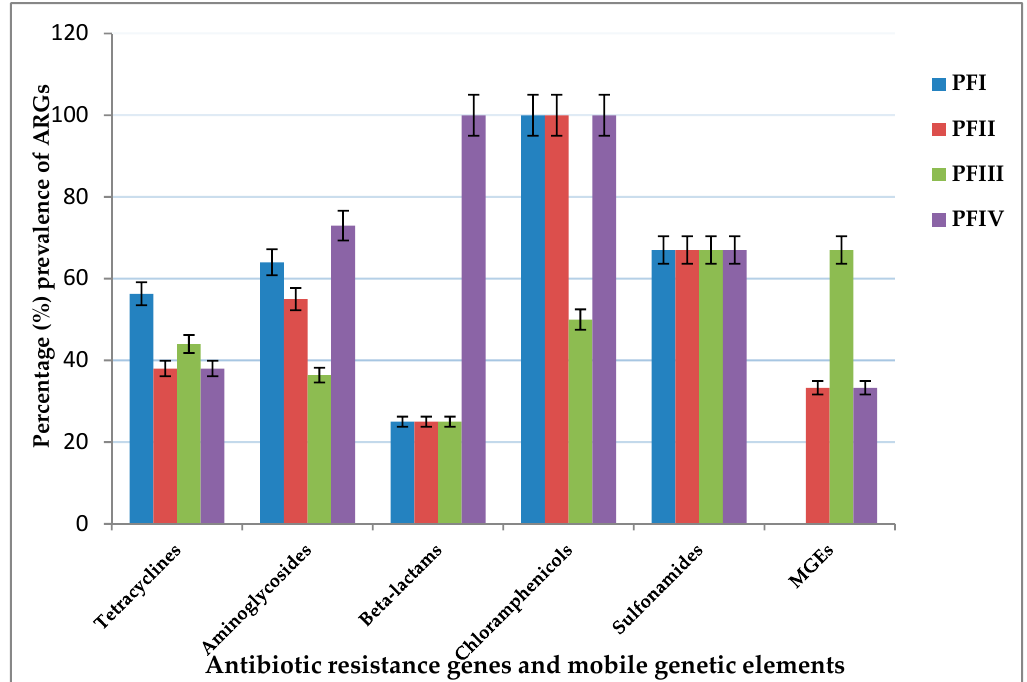
Figure 1. Percentage ARGs and integrons tested positive in metagenomic DNA samples obtained from pharmaceutical wastewaters.